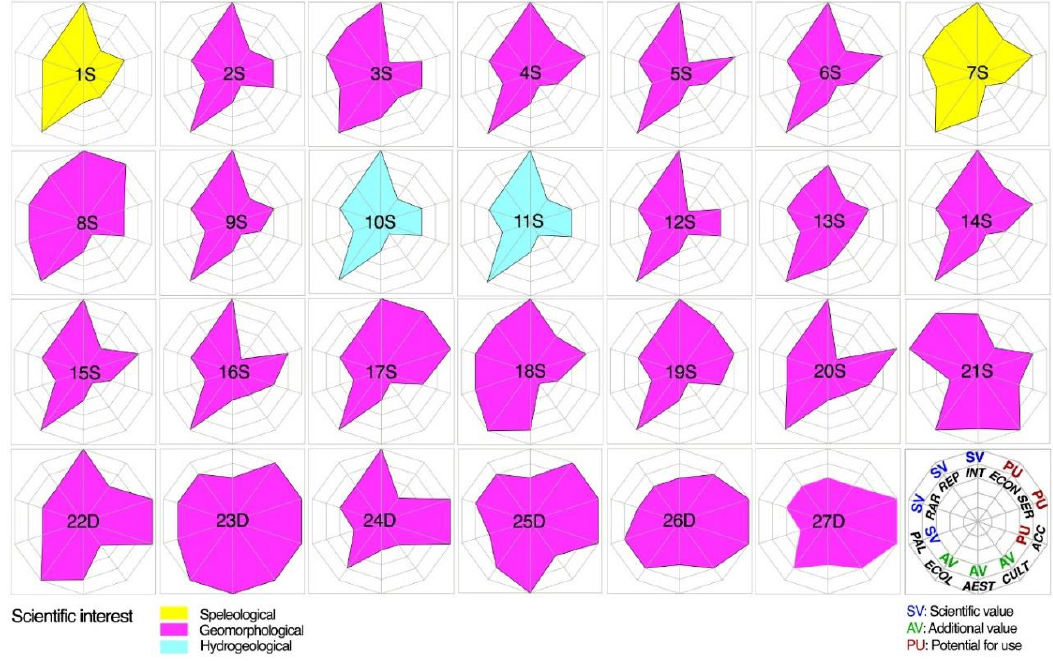
Figure 7. Multivariate representation of the results of marine geosite assessment. Along the axes, the quantitative results of the assessment of the scientific, additional, and potential for use values and their sub-criteria are shown for each marine geosite. The colors represent different scientific interests, as specified in the figure legend.